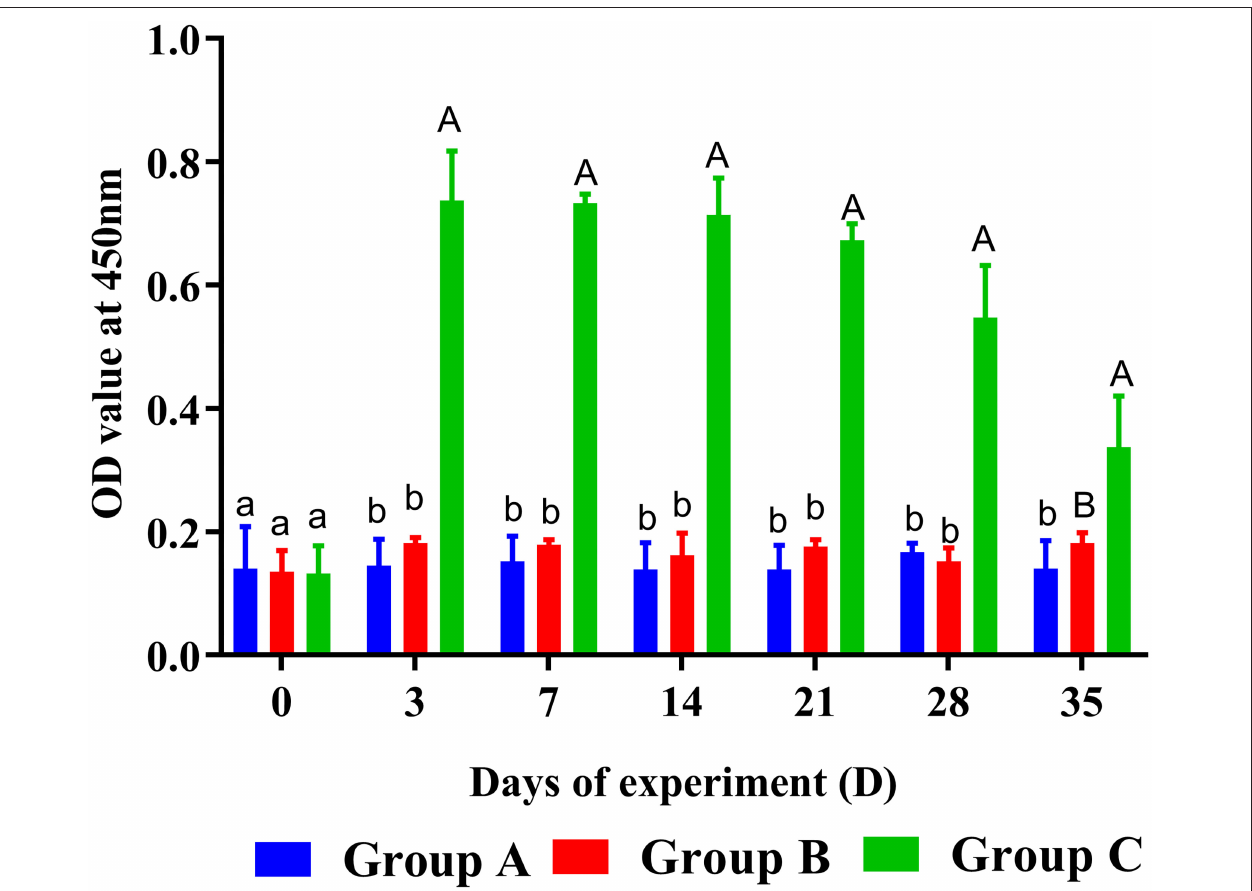
FIGURE 3 | Dynamics of rHc8-specific IgG in sera of trial 1. Group A, unchallenged goats; Group B, goats challenged with L3s at day 1; Group C, goats challenged with L3s at day 1 and then immunized by PcAb-rHc8 antibodies at days 2 and 3 post challenge. Data were expressed as mean ± SEM. Same letter indicates nonsignificant difference ( p > 0.05). The different lowercase letters indicate significantly different values at p < 0.05. Different uppercase and lowercase letters indicate significantly different values p <